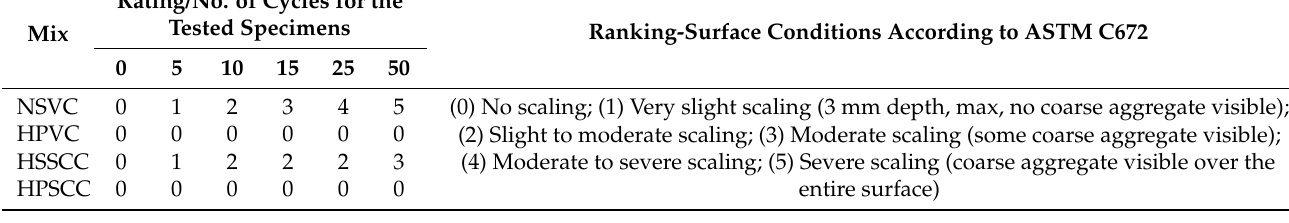
Figure 8. Rating of the concrete surface can be evaluated by loss of concrete mass and visibility of gravel particles, whereas the interesting parameter in a practical point of view is the thickness of the deteriorated concrete, therefore it is better to determine the loss in thickness of the concrete which exposed to freezing and thawing cycles. Table 9 is also showing the concrete depth lost by the action of thermal stresses. Table 10. Rating of concrete specimens in scaling test ASTM C672.